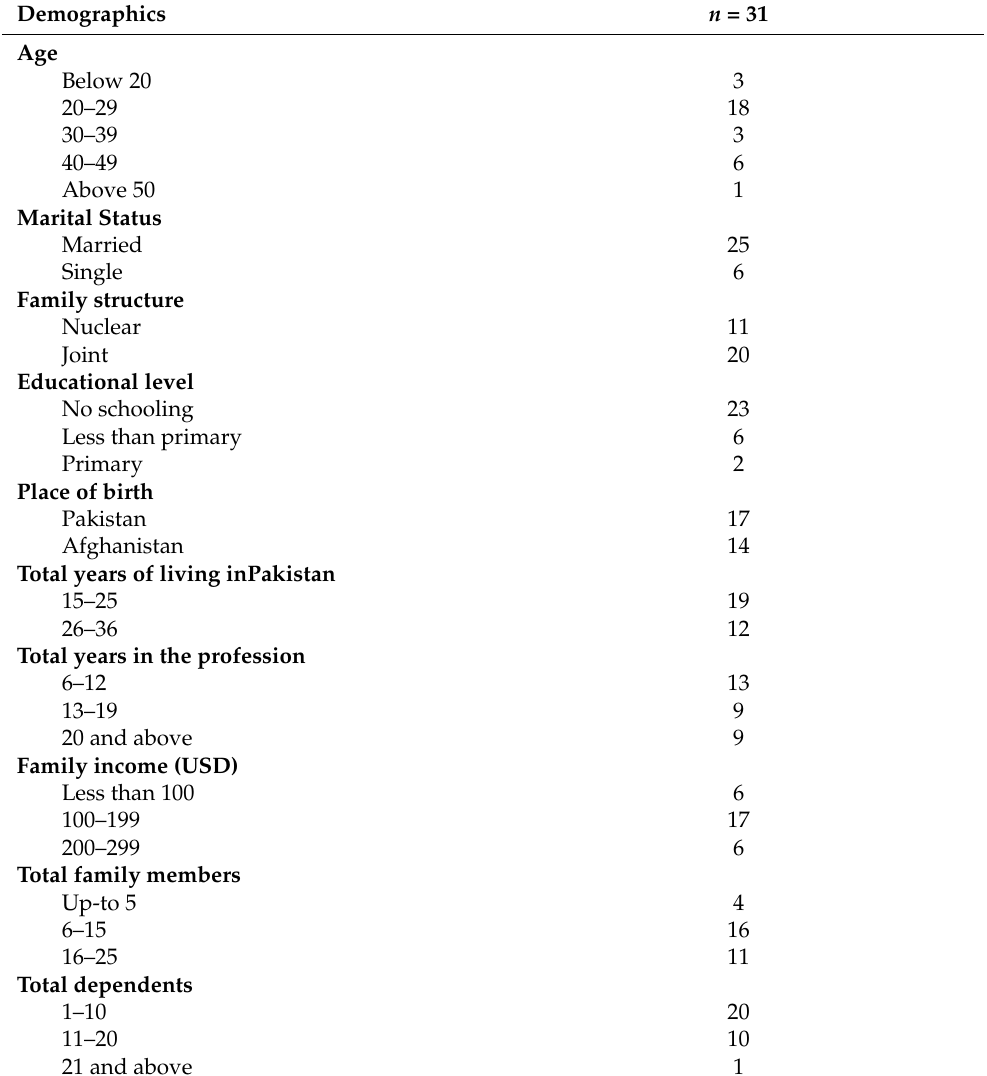
Table 1. Participants’